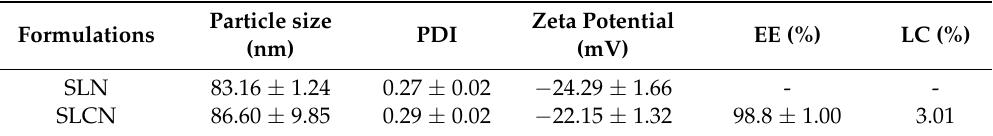
Table 1. Physical properties of solid lipid nanoparticles (SLN) and curcumin-loaded solid lipid nanoparticles (SLCN).